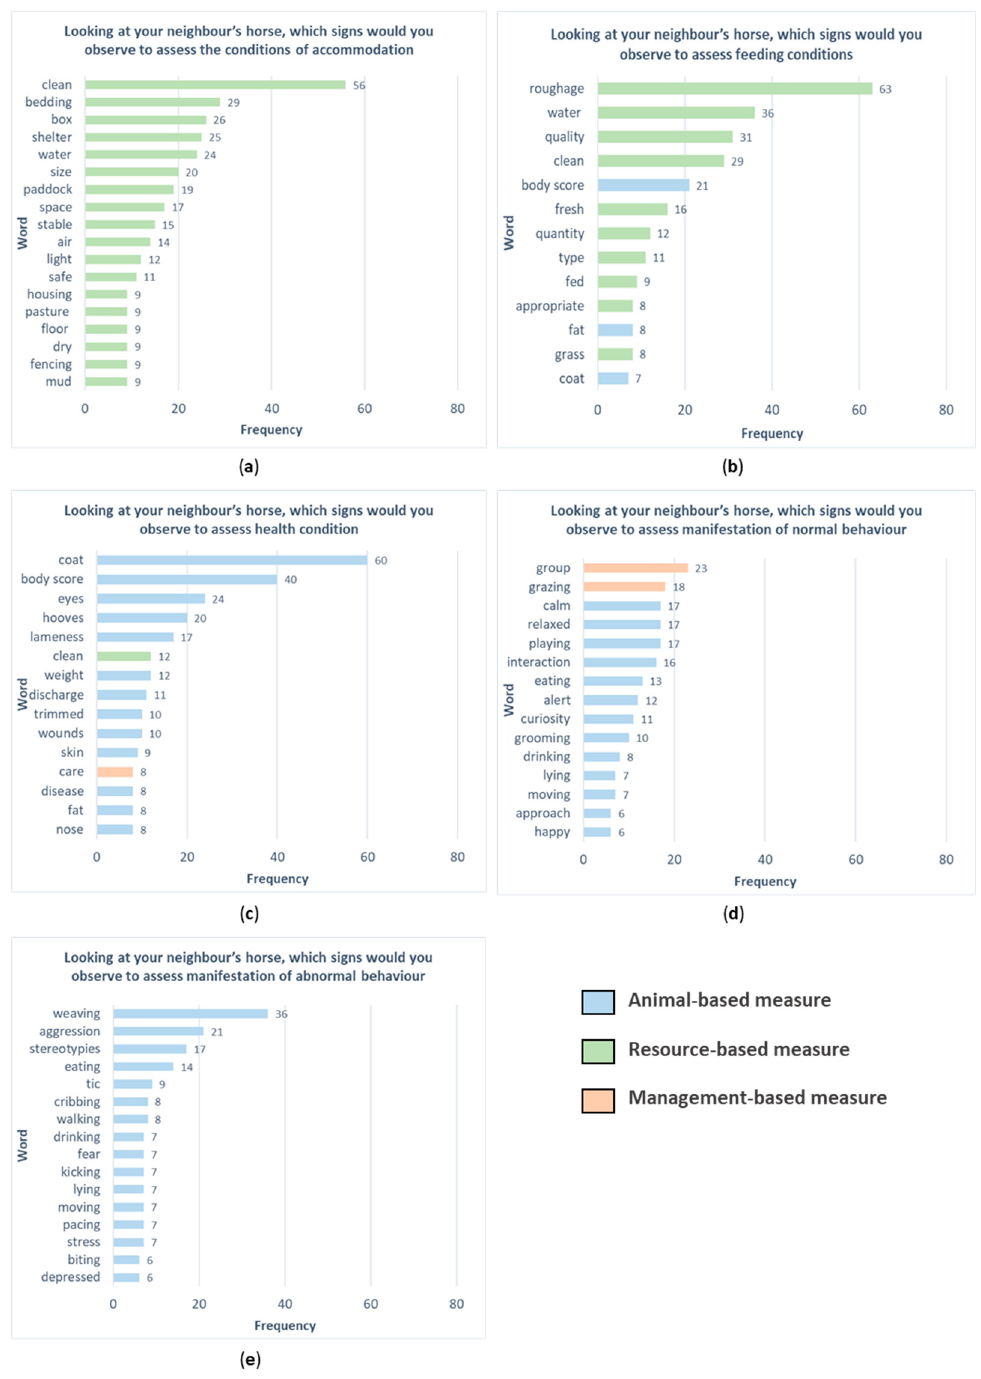
Figure 2. The graphs report the frequency of words for each of the five questions: “Looking at your neighbour’s horse, which signs would you observe to assess the conditions of accommodation ( a ), feeding conditions ( b ), health condition ( c ) manifestation of normal behaviour, ( d ) and manifestation of abnormal behaviour ( e )?”. Different colors highlight the type of measure (animal-, resource- or